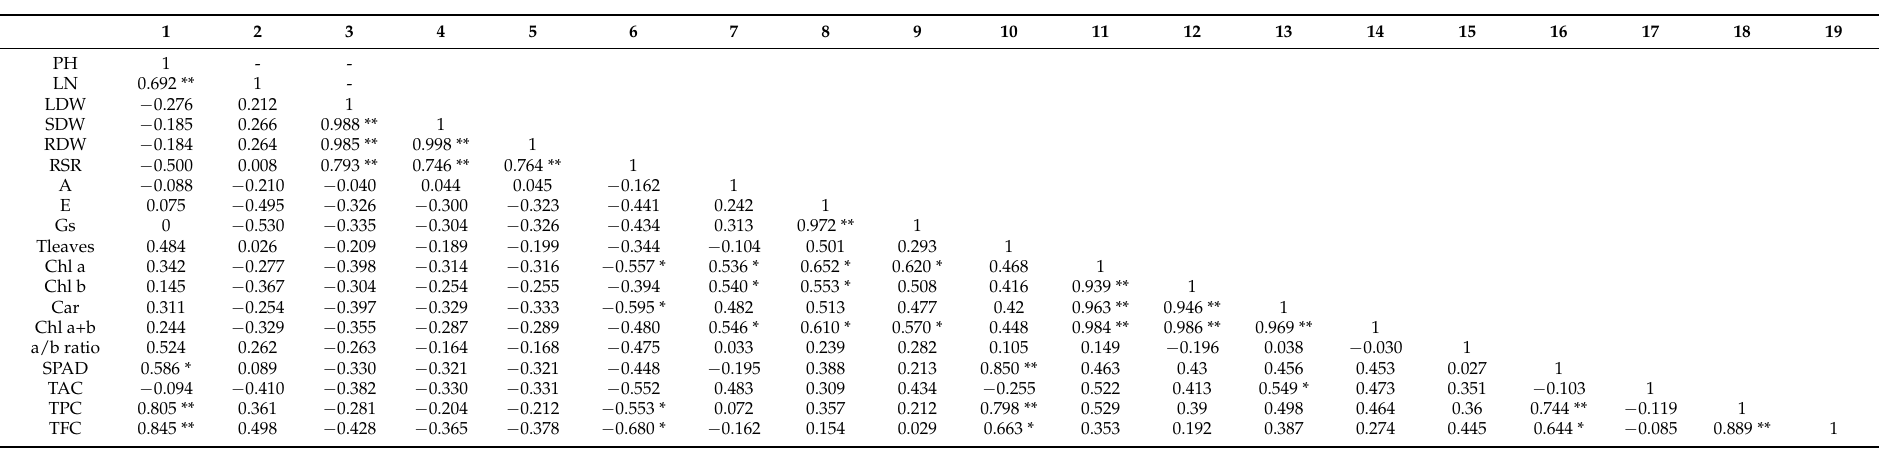
Table 2. Significant Pearson’s correlation between parameters measured in this experiment. The (*) indicates significant difference at p ≤ 0.05 while (**) indicates significant different at p ≤